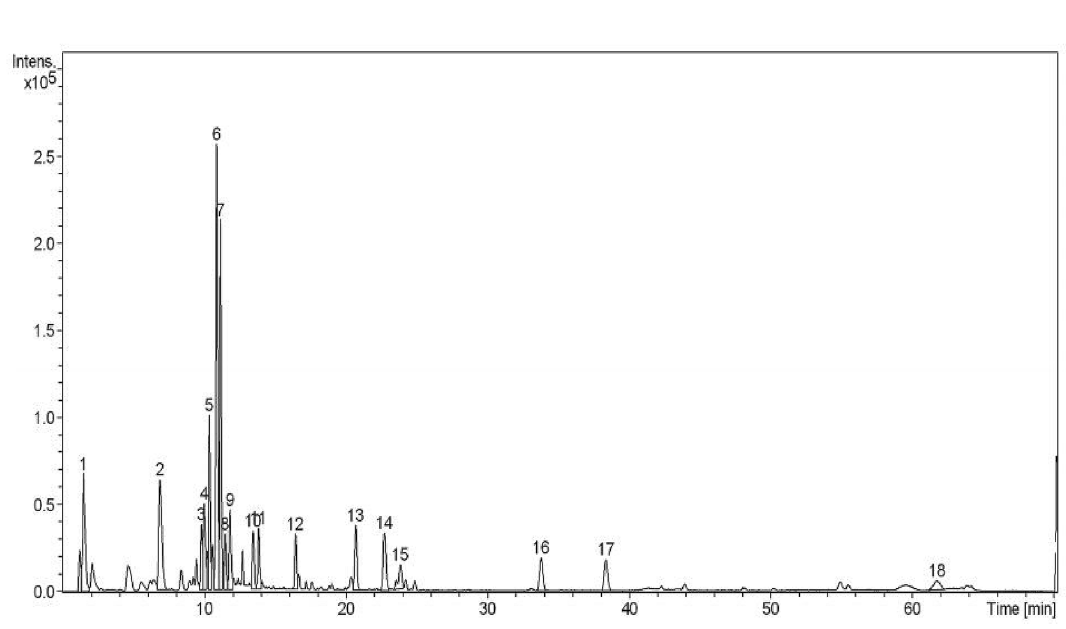
Figure 8. LC–MS fingerprinting analysis of fruits of F. auriculata analysed in the negative ionization